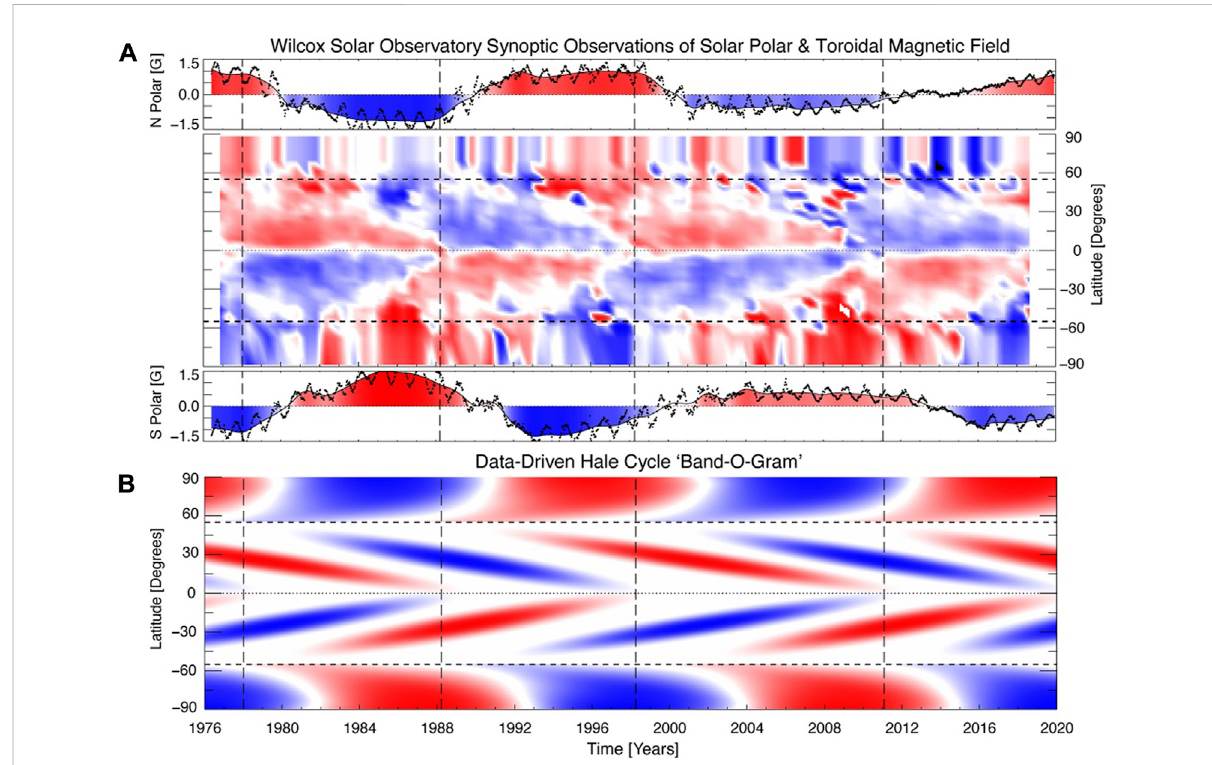
FIGURE 3 Comparing and contrasting the WSO toroidal magnetic fi eld [Panel (A) , see Figure 2B and now expressed in latitude] and polar cap measurementswiththedata-inspiredband-o-gram (B) ( cf. Figure1C)nowextendedtocovertheWSOrecord.Thehorizontaldashedlinesindicatea latitude of 55 ° while the vertical dashed lines shown in each panel mark the times of the Hale Cycle termination events studied by M2019.